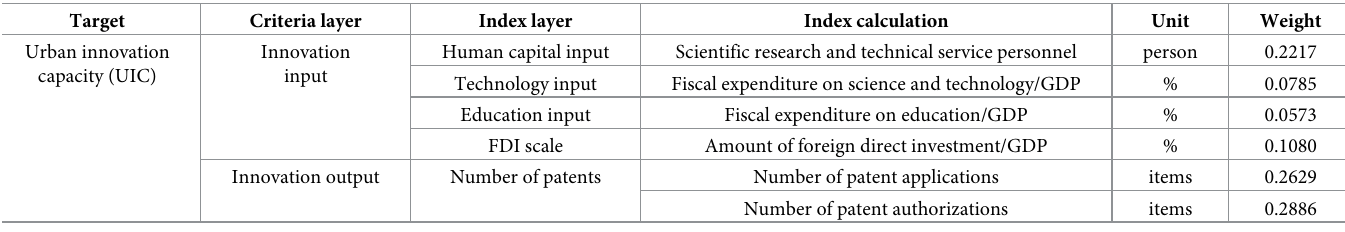
Table 1. Index of urban